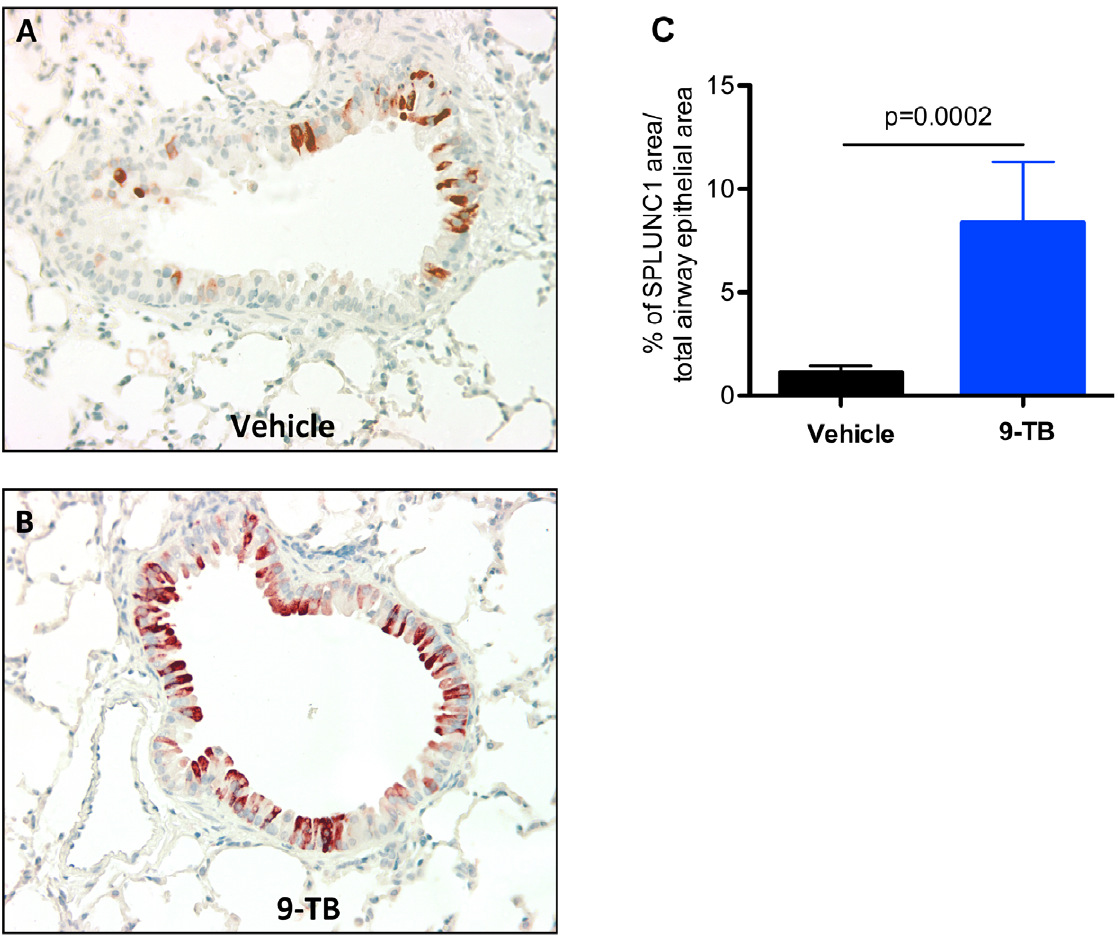
Figure 6. 9-TB up-regulates airway epithelial SPLUNC1 protein in CC10- CA IKK b transgene positive (Tg + ) mice. Lungs from saline- treated Tg + mice were processed for SPLUNC1 immunohistochemistry. Representative SPLUNC1 staining in medium-size airways of Tg + mice treated with vehicle solution ( A ) and 9-TB ( B ). Quantitative data of airway SPLUNC1 protein ( C ) are expressed as a percentage of stained area versus total (stained plus non-stained) airway epithelial area. N=4 mice per group. Data are expressed as means 6 SEM.